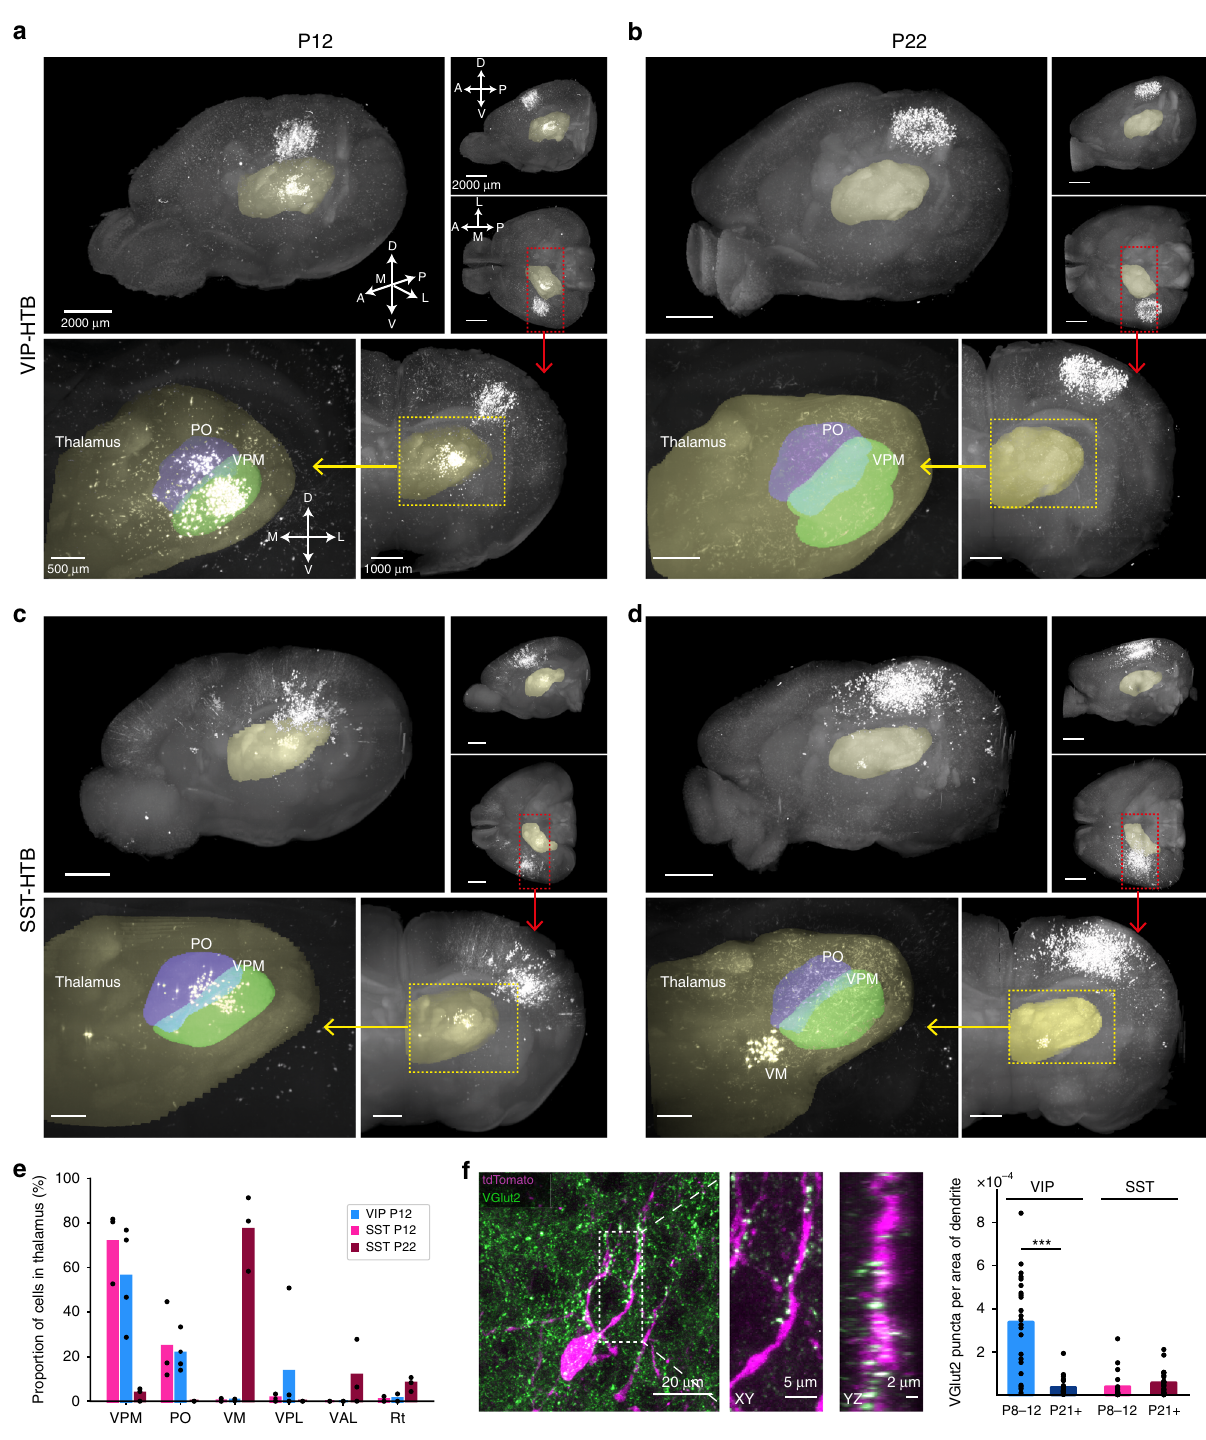
Fig. 4 Rearrangement of thalamic inputs onto super fi cial VIP + and SST + interneurons during development. a – d Top panel: representative examples of cleared rabies injected brains seen from an oblique, top-down and side angle. The thalamus is highlighted in yellow. The red square indicates the area projected in bottom panel. Bottom panel: Coronal view of maximum intensity projection of the thalamus. Left: overview. Right: zoom-in with VPM (green) and PO (blue) highlighted. N = 3 brains for SST; N = 4 brains for VIP P12). e Quanti fi cation of pre-synaptic cells in different thalamic nuclei normalized to the total number of cells in the thalamus. VIP P22 is not included because no cells were found in the thalamus. Same number of brains as in a – e. f Example of VGlut2 staining (green) in L2/3 of a wS1 section from a VIPCre-tdTomato animal at P9. The dotted square indicates the zoomed-in part on the right, which shows a close-up of puncta appositions in xy and yz direction. The graph shows quanti fi cation of VGlut2 puncta on tdTomato-positive dendrites. The number of appositions in every picture is normalized to the area of tdTomato positive dendrites in the same picture. ( N = 3 brains per group; VIP P8 – 12: 23 images, VIP P21 + : 27 images, SST P8 – 12: 21 images SST P21 + : 28 images. Statistics: two-sided Mann – Whitney U test, p (VIP) = 2.492 × 10 − 7 . Source data are provided as a Source data fi